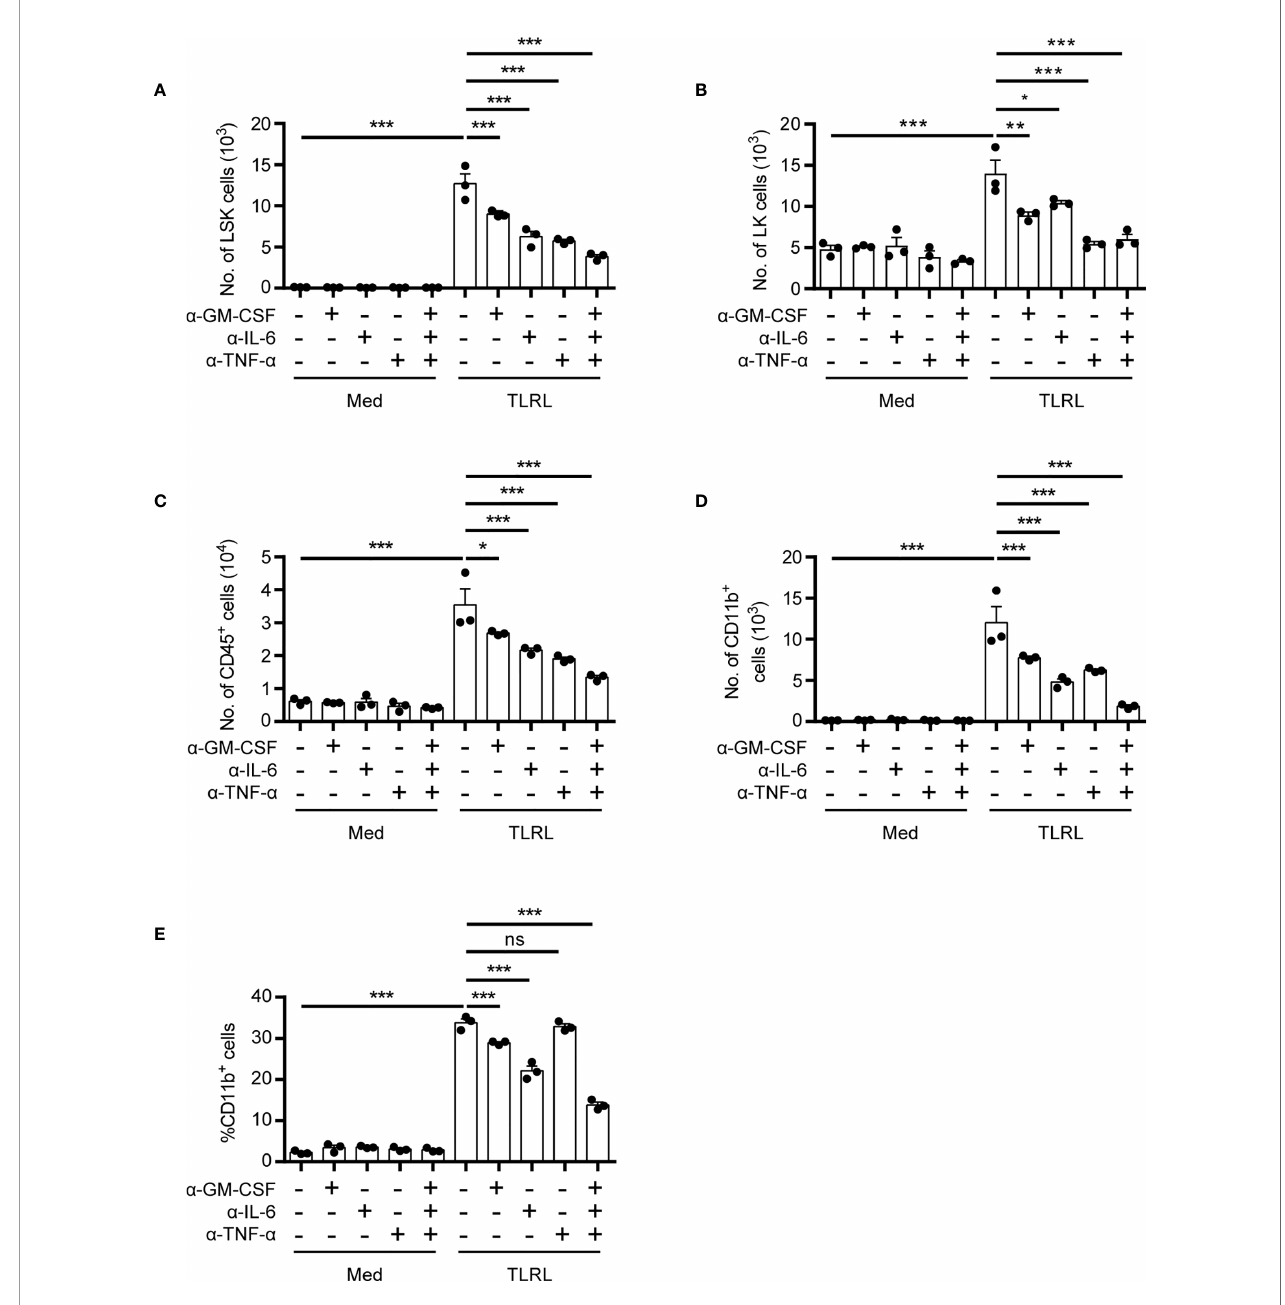
FIGURE 2 | Functional impact of HSPC-produced cytokines on myelopoiesis in response to TLR stimulation. Analysis of the in vitro myelopoiesis of LSK cells by fl ow cytometry. Sorted LSK cells (1,000 cells per 100 m l medium) were cultured in IMDM supplemented with FBS (10%, v/v), SCF (50 ng/ml), with or without the addition of LPS (100 ng/ml), Pam3CSK4 (1 mg/ml), and the indicated cytokine-neutralizing antibodies. Cells were analyzed on day 4 by fl ow cytometry. Numbers of LSK cells (A) , LK cells (B) , CD45 + total immune cells (C) , and the number (D) and percentage (E) of CD11b + myeloid cells were examined. Columns represent the mean of results from three separate experiments, and error bars represent the SEM. * P < 0.05, ** P < 0.01, *** P < 0.001; ns, not signi fi cant, by 1-way ANOVA followed by Dunnett ’ s